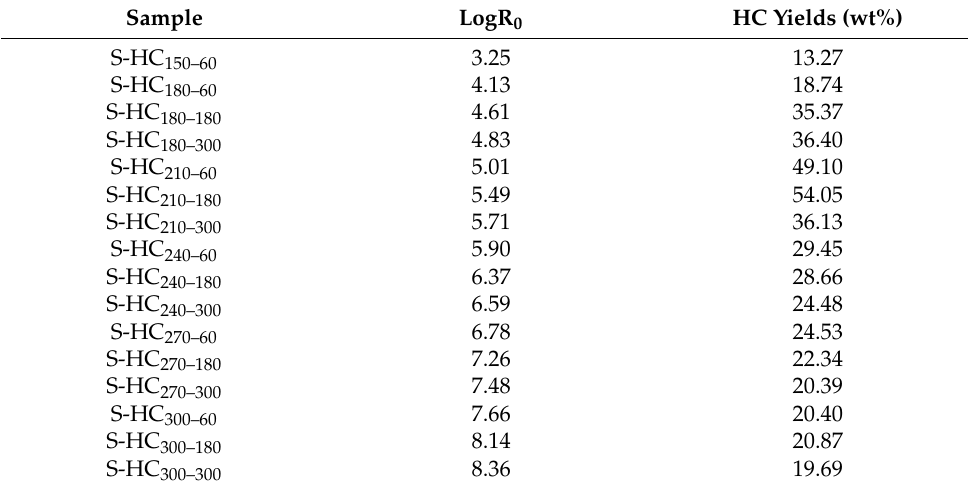
Table 1. Hydrochar yields as a function of logR 0